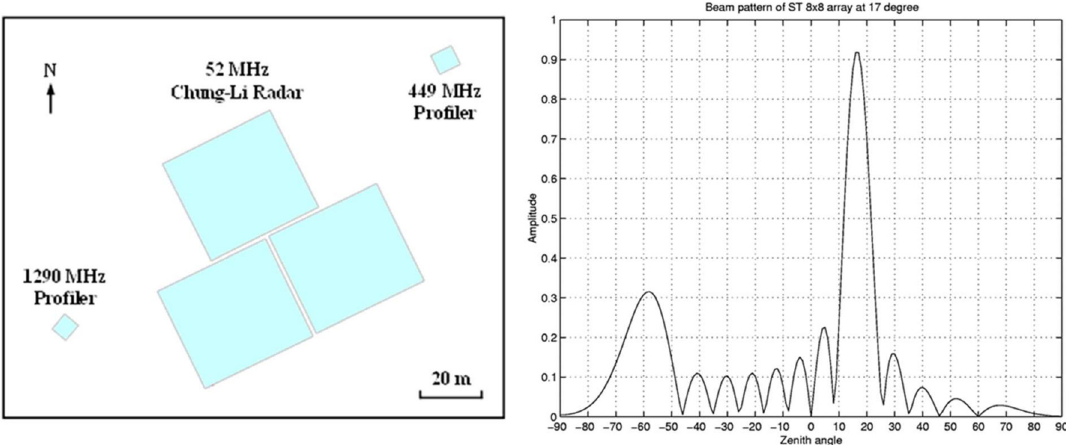
Figure 1. Antenna arrays of the wind profiler radars operated at 52 MHz, 449 MHz, and 1290 MHz, deployed at the campus of National Central University ( left ), and antenna beam pattern of obliquely pointed radar beam for Chung-Li VHF radar ( right ).